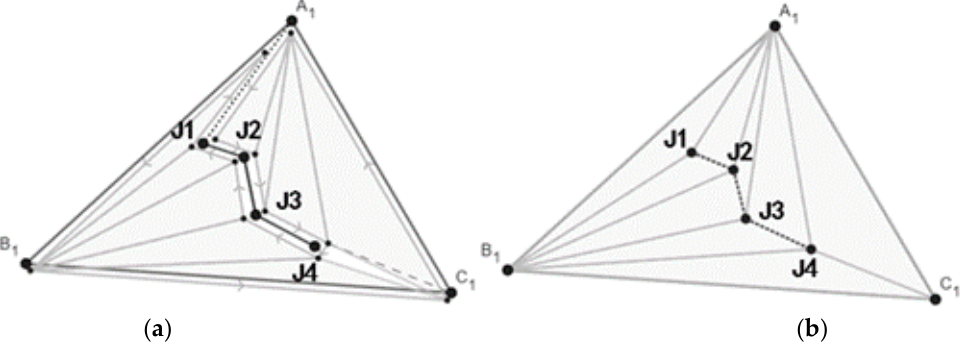
Figure 10. Schematic diagram of triangulation cutting of intersecting triangles. Deleting all points on the closed polygon except the vertex in ( a ) to generate ( b ).